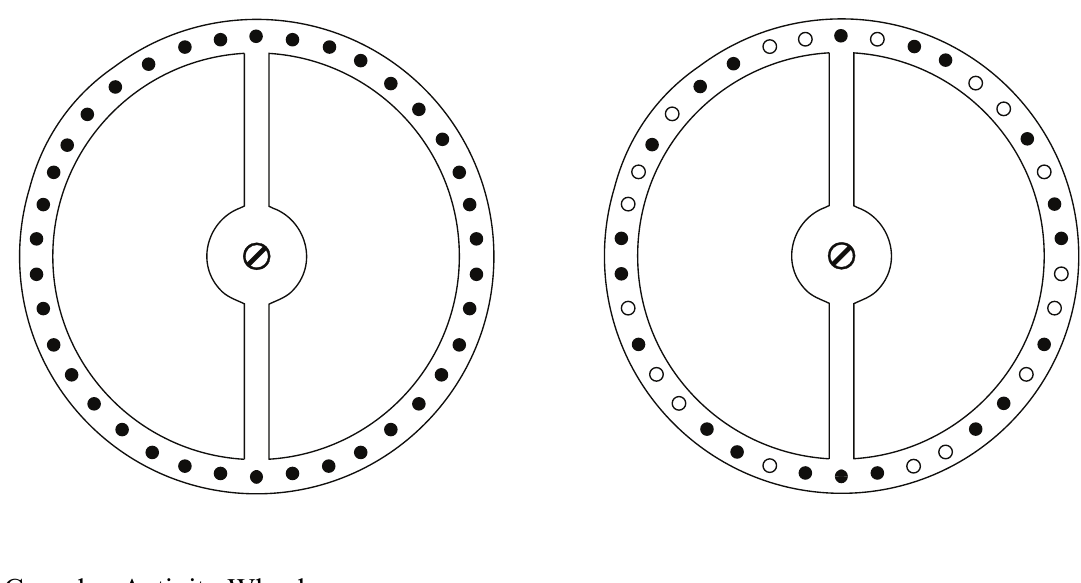
Figure 1. Schematic representation of normal and complex activity wheels. ( A ) Baseline activity was measured on a normal activity wheel that contained a full complement of 38 consecutive rungs. ( B ) Fine motor co-ordination was evaluated using a complex activity wheel that involved the use of a customized wheel in which 18 crossbars or rungs were removed at irregularly spaced intervals. The dark circles represent the presence of a rung and white circles represent a removed